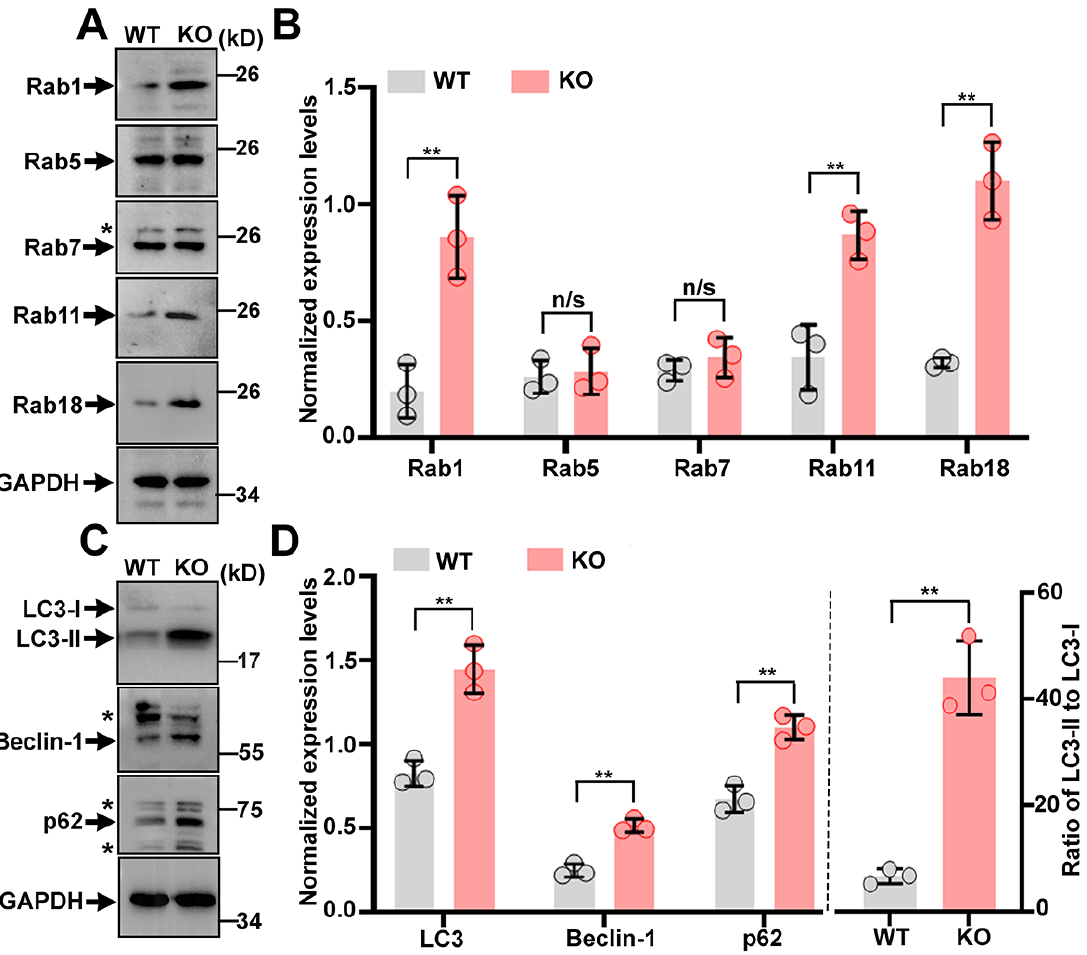
Figure 4. Trappc9 loss impacts the expression of rab proteins and autophagy in ASCs. Post-nuclear supernatants prepared from WT and trappc9-deficient (KO) ASCs at passage-4 were subjected to SDS-PAGE and Western blot analysis with antibodies for indicated rab proteins ( A , B ) and proteins related to autophagy ( C , D ). GAPDH was a loading control. Blot analyses shown in ( A , C ) were from one of three independent experiments. Densitometry quantification of signal intensities for each of the indicated proteins were graphed and shown in ( C , D ), respectively. Expression levels of indi- cated proteins were normalized with signal intensities of the corresponding GAPDH. Star symbols beside gel graphs indicated proteins cross-reactive to the corresponding antibodies. Data are Mean ± SD. Each symbol in ( B , D ) represents one experiment. Unpaired two- tailed Student’s t -test: * p <0.05; ** p < 0.01; n/s, no significance.